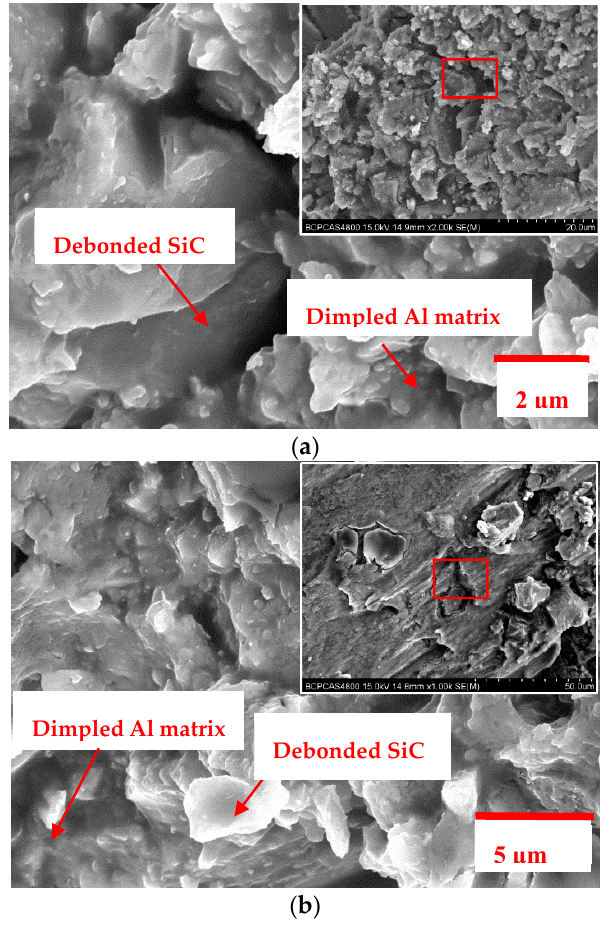
Figure 8. Fracture morphologies of Al6063/SiC p /65p composites after ( a ) uniaxial compression and ( b ) machining.